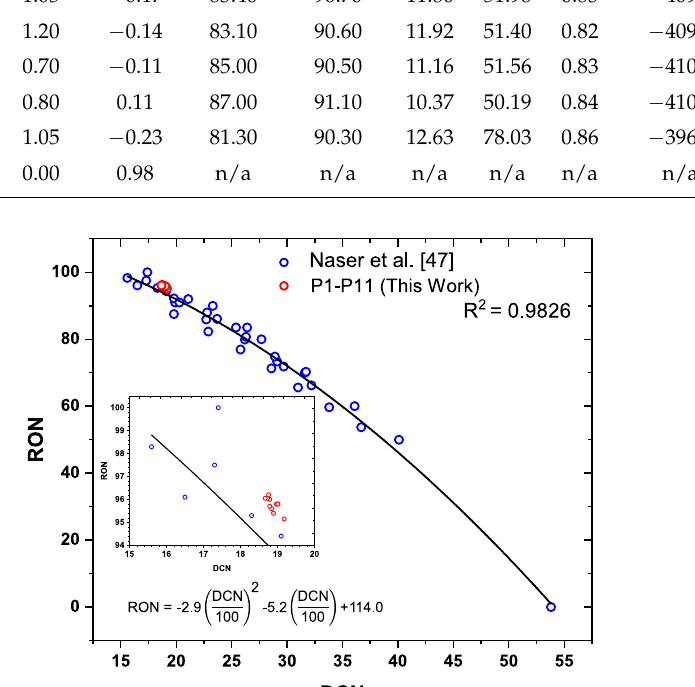
Figure 3. Comparison of the Derived Cetane Number (DCN) to research octane number (RON) correlation from Naser et al. [47] (blue) and this work (red). From this work, the RON was measured according to ASTM D699 and the DCN was measured using ASTM D6890 for a RON = 95, DCN = 18.9 gasoline treated with 1 mole % of phenol model compounds P1–P12 (Table S1). Inset: Shows an expansion of the DCN and RON regions tested in this